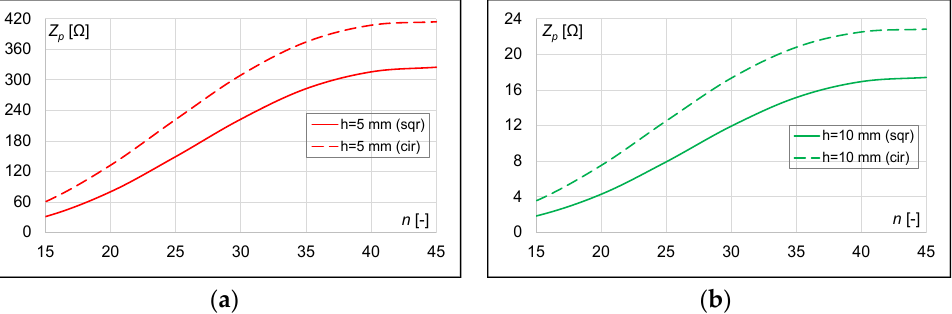
Figure 17. Load impedance at f max to obtain maximum load power for coil with r = 10 mm at distances: ( a ) h = 0.5 r ; ( b ) h = r .